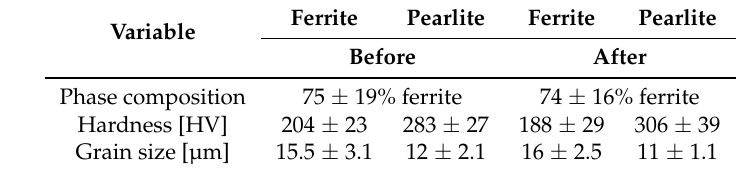
Table 3. Hardness, grain size and phase composition measured before and after heat treatment.